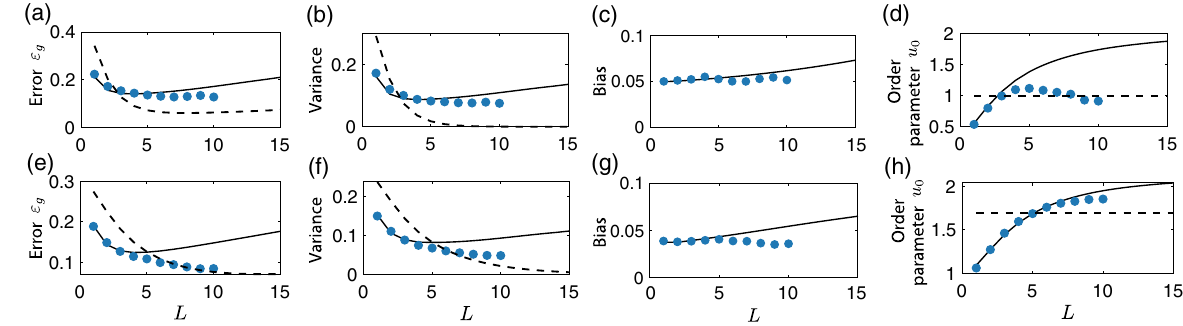
FIG. 15. Generalization error of deep ReLU networks as a function of depth L . Blue dots: simulation. Black solid lines: theoretical approximation. Black dashed lines: GP limit. (a,e) Generalization error, (b,f) variance, and (c,g) bias of the predictor, and (d,h) the order parameter u 0 . (a) – (d) Results for the template model with noisy linear teacher labels, with the parameters in Appendix E. (e) – (h) Results for a binary MNIST classification task with parameters in Appendix